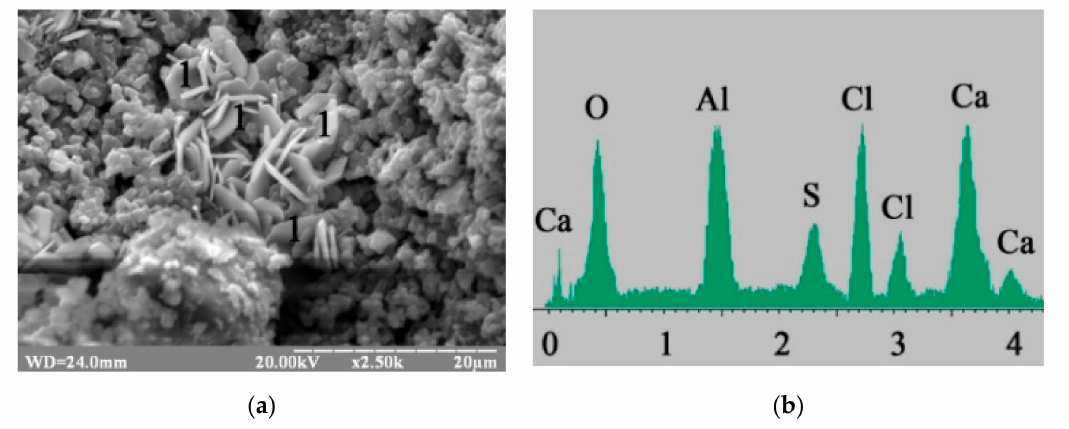
Figure 5. Microstructure of the 180-day hydrated blast furnace cement mixed with sea water and containing Na 2 CO 3 in combination with calcium aluminate cement as minor additional constituents: ( a) SEM image; ( b ) Microprobe analysis in point 1.